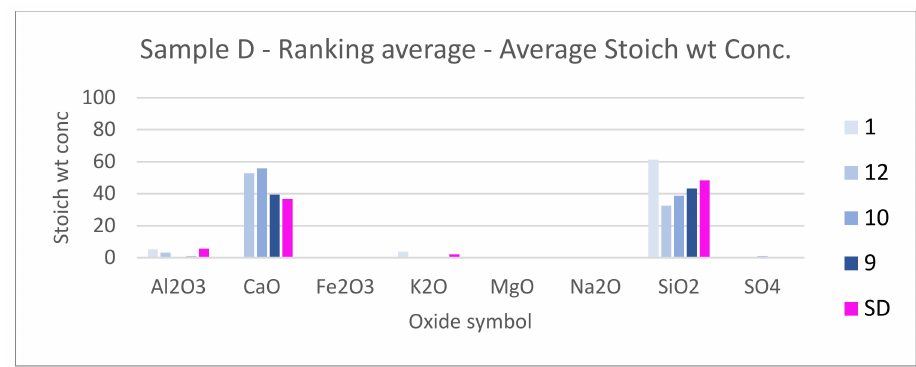
Figure 26. Sample D—ranking average—average stoich wt